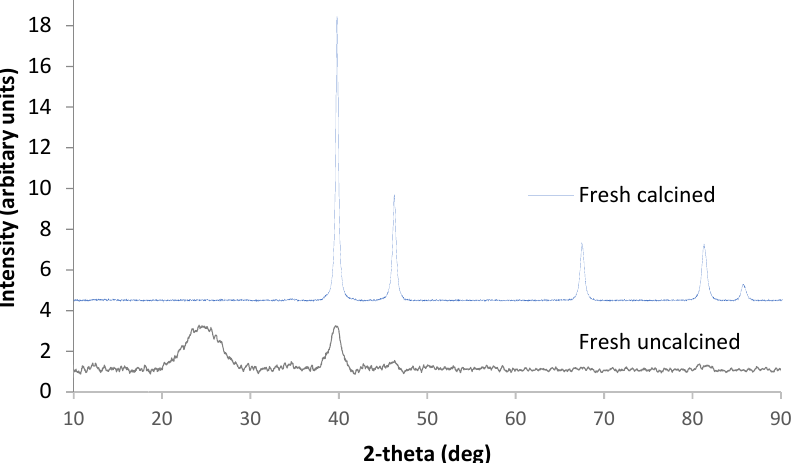
Figure 2. XRD spectra of the fresh uncalcined and fresh calcined Pt/C.